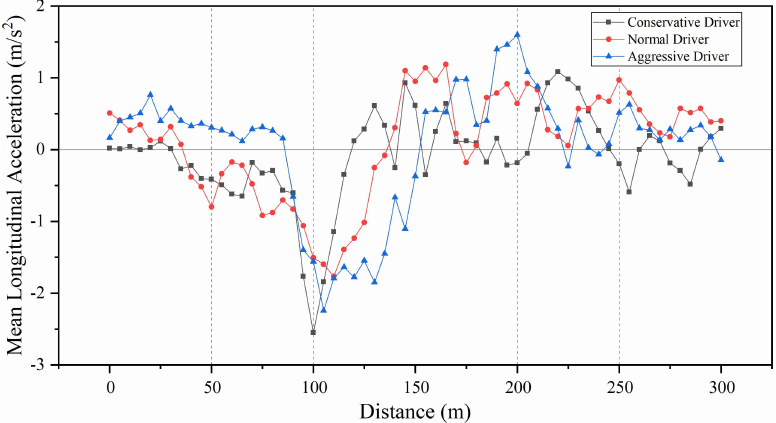
Figure 6. Mean longitudinal acceleration for three types of